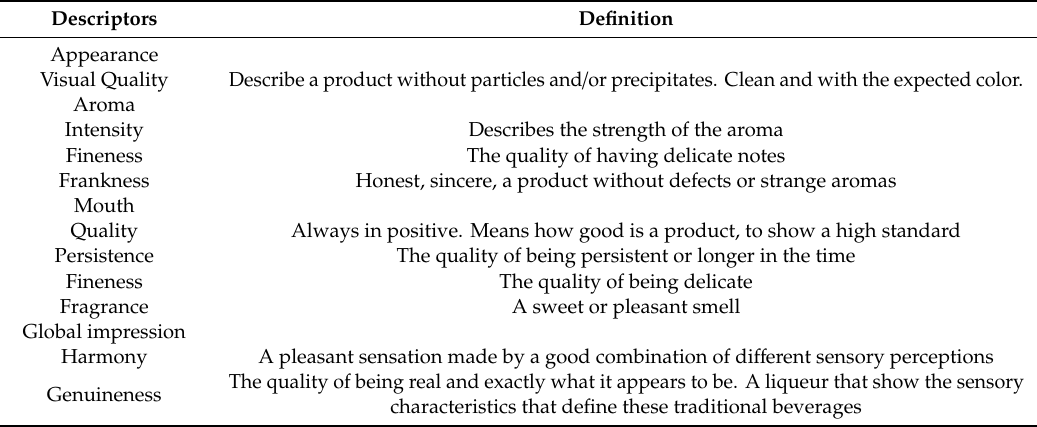
Table 4. Attributes selected to qualify the global quality in liqueurs and their corresponding